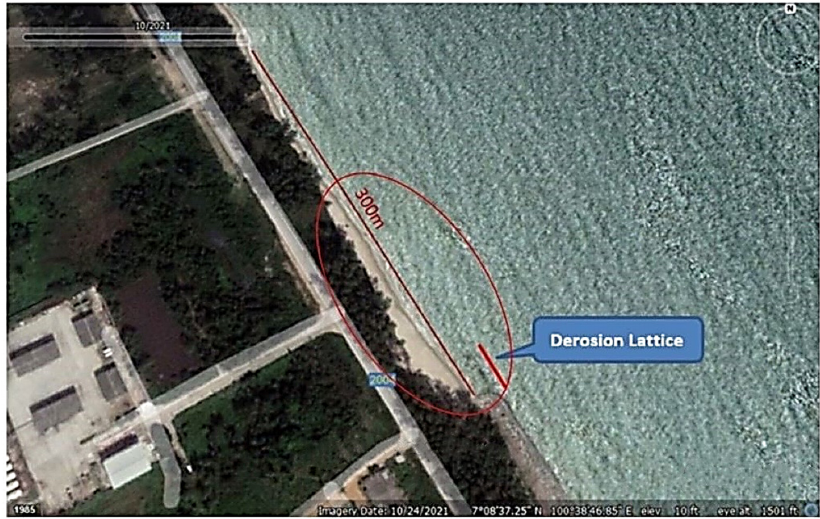
Figure 18. The images by Google Earth: two months later after the DL